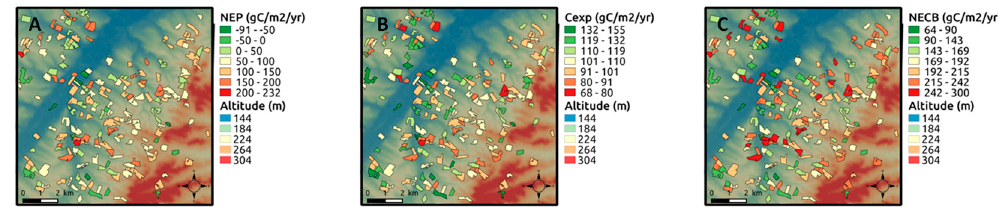
Figure 10. The annual carbon budget (NECB) and its component, NEP and Cexp, simulated for 200 fields with SAFY ‐ CO 2 inside the study area for CY ‐ 15. Digital elevation model from Shuttle Radar Topography Mission is displayed in the